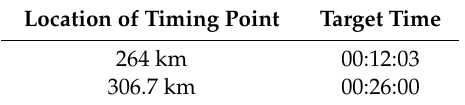
Table 3. Location and target of timing points in the case of one intermediate timing